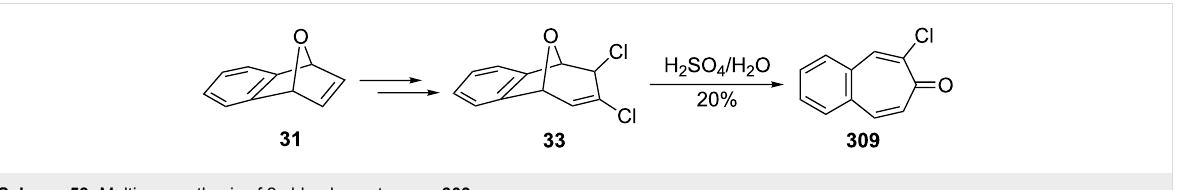
Scheme 53: Multisep synthesis of 2-chlorobenzotropone 309 .